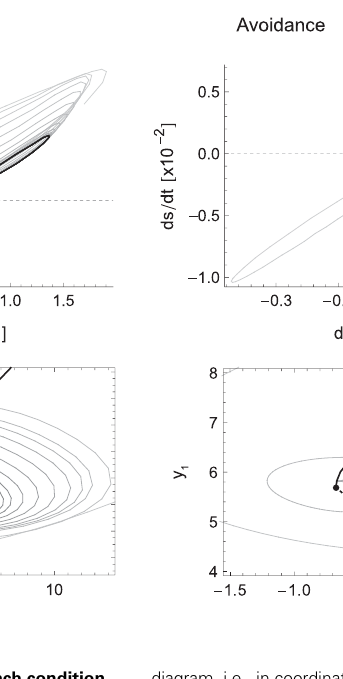
FIGURE 6 | Sensorimotor coordination patterns for approach condition (left) and avoidance (right) .Top row: change in sensory activation (ds/dt) as a function of change in motor commands (dm/dt) during the agent’s interaction with the bell shape. After an initial transient, the system settles into a stable oscillation in the approach but not the avoidance condition. Bottom row: the same coordination patterns as trajectories in the hidden neuron’s bifurcation